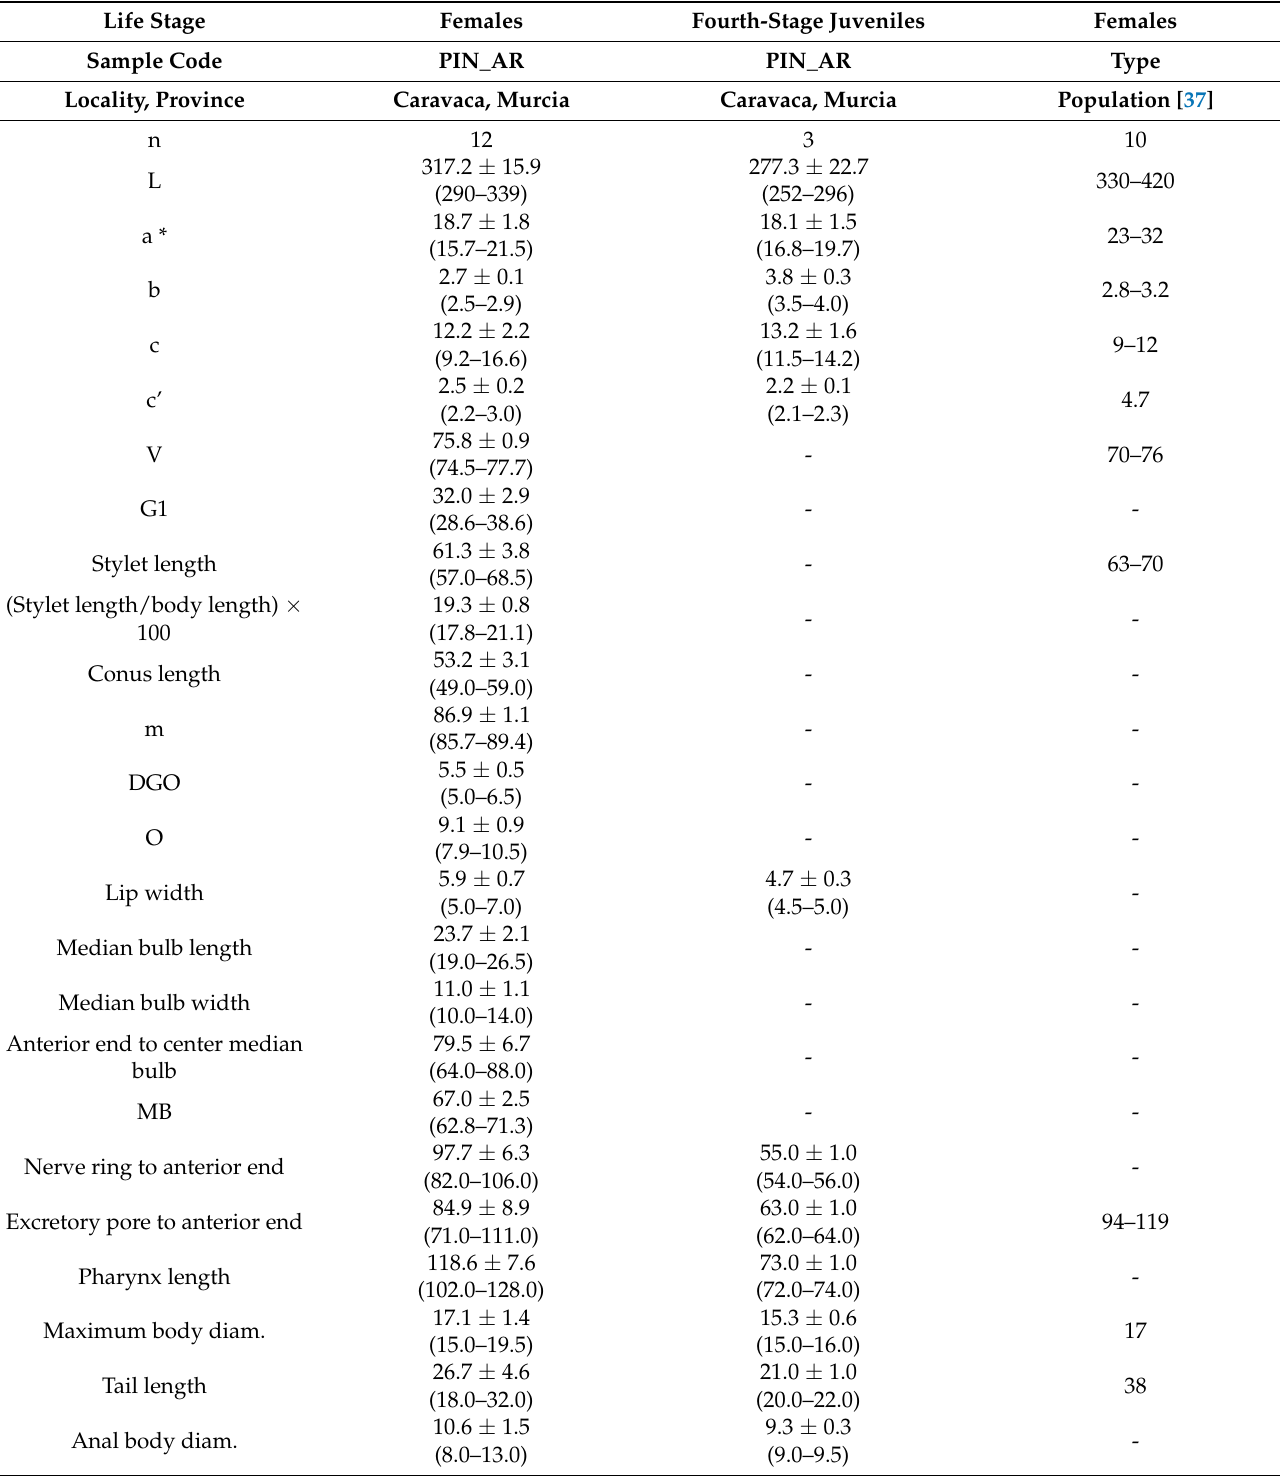
Table 8. Morphometrics of Paratylenchus pandatus (Raski, 1976) Siddiqi, 1986 from Caravaca, Murcia, Spain. All measure- ments are in µ m and in the form: mean ± s.d.